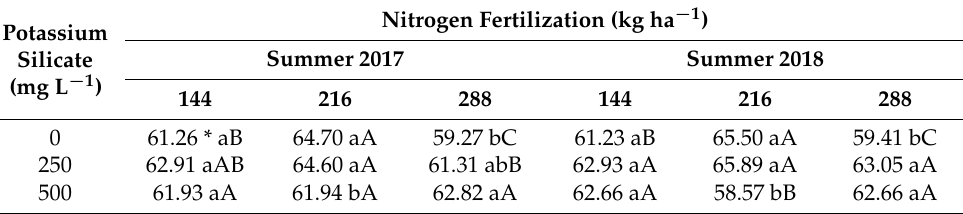
Table 3. Means of leaf chlorophyll content (g kg − 1 ) as affected by the nitrogen fertilization × potassium silicate interaction during 2017 and 2018.